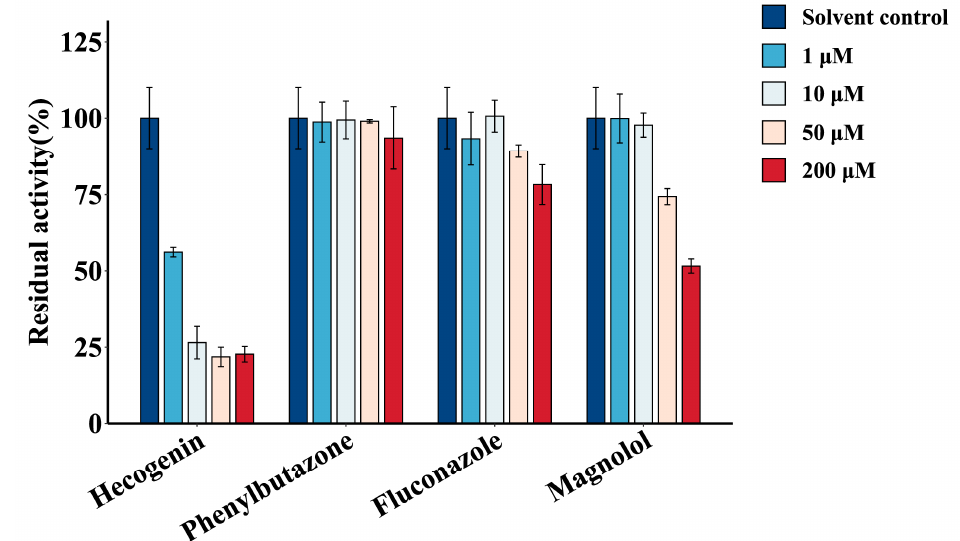
Figure 4. Chemical inhibition of GPC glucuronidation in human liver microsomes by four different inhibitors (1, 10, 50, and 200 μ M) (hecogenin, phenylbutazone, fluconazole, magnolol) (GPC concentration of 15 μ M). The incubation without inhibitor, but with the same volume of DMSO was set as the solvent control, and the control activity was set to 100%.